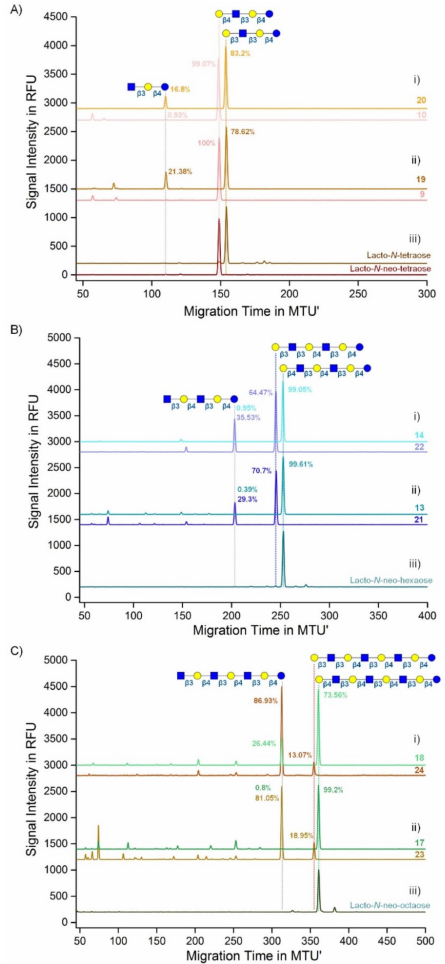
Figure1. Multiplexedcapillarygelelectrophoresiswithlaser-inducedfluorescencedetection(xCGE-LIF) analysis of the linear HMOS synthesis products: tetraoses ( A ), hexaoses ( B ), and octaoses ( C ). Upper electropherograms show ( i ) 13 C 6 galactose-enriched compounds 10, 14 , 18 , 20 , 22, and 24 and ( ii ) centered native compounds 9 , 13 , 17 , 19 , 21 , and 23 . The bottom electropherograms display ( iii ) the migration time matching with commercially available standards. Lacto- N -neo-type HMOS were analyzed after 24 h reaction time, while the final reaction step for Lacto- N -type (terminal β 3Gal) compounds was carried out after 72 h. Symbolic representation of oligosaccharide structures is drawn with GlycoWorkbench v.1.0.3353 by the guidelines of the Consortium for Functional Glycomics: blue circle, glucose; blue square, N -acetylglucosamine; yellow circle, galactose